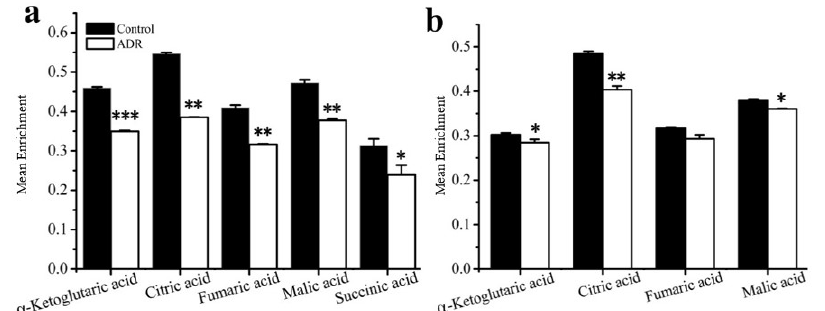
Figure 4. Mean enrichment of TCA cycle intermediates for non-treated cells and ADR-treated cells by isotope tracing analysis: ( a ) MCF7, ( b ) MDA-MB-231. * signifies p < 0.05; ** signifies p < 0.005 and *** signifies p < 0.0001.